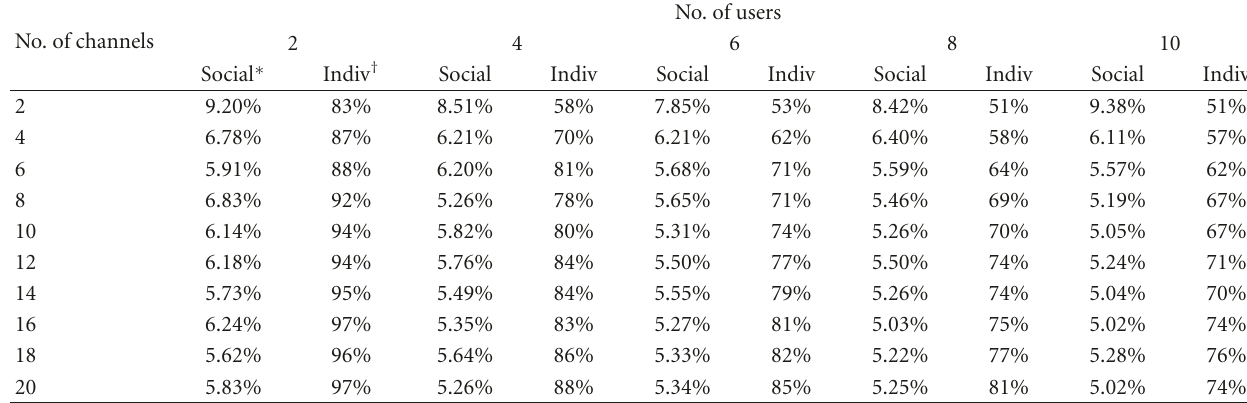
Table 4: Comparisons of social utility and individual utility between competitive equilibrium(CE) with power demands d i = Nash equilibrium(NE), error tolerance = 0.01 and average of 100 simulation